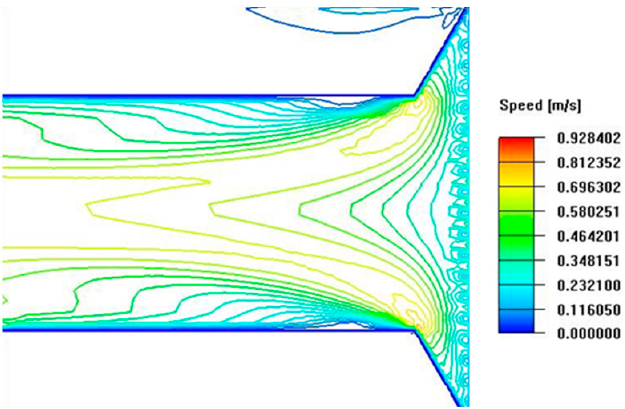
Figure 11. The flow velocity of the guide cover.